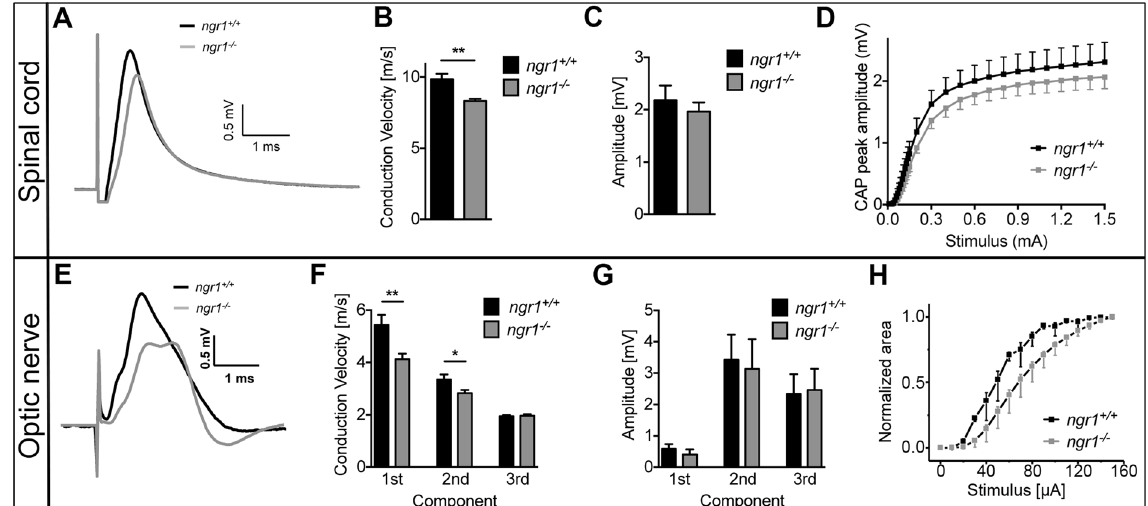
Figure 5. Delayed latencies of CAP recordings from the CNS of ngr1 − / − mice. ( A ) Representative recordings of CAP series from naïve spinal cords from ngr1 + / + and ngr1 − / − mice as measured by sucrose gap showed delayed CV in ngr1 − / − . ( B ) CVs and ( C ) amplitudes were measured at peak maxima. ( D ) Axon recruitment profiles for the peak amplitude. ( F ) Representative recordings of CAP series from naïve optic nerves from ngr1 + / + and ngr1 − / − mice as measured by suction electrodes showed delayed CV in ngr1 − / − . ( F ) CVs and ( G ) amplitudes were measured at peak maxima. ( H ) Axon recruitment profiles for the peak amplitude ( n = 6 for ngr1 + / + and n = 9 for ngr1 − / −